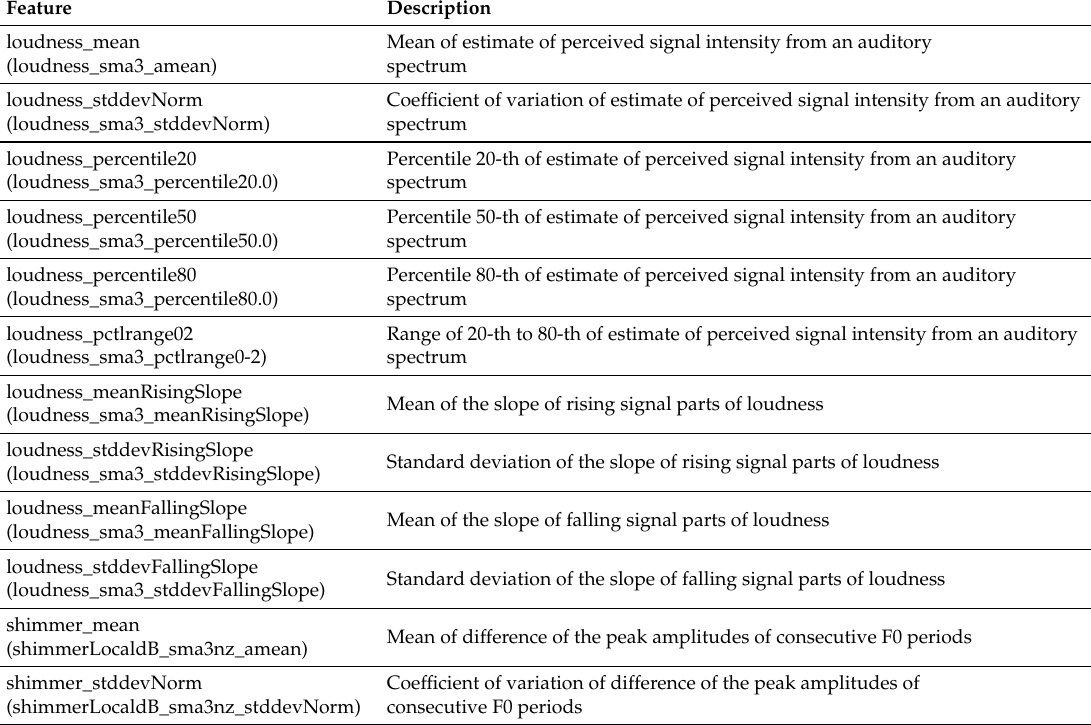
Table A2. Energy features explained. All functionals are applied to voiced and unvoiced regions together. Text in brackets shows the original name of the eGeMAPS features.